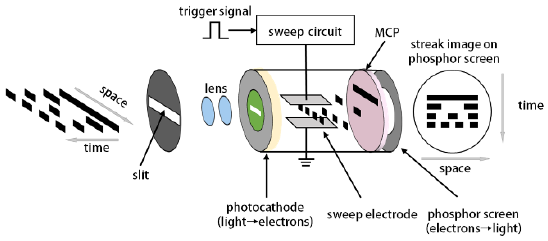
Figure 1. Schematic diagram of the imaging process of the streak camera in one-dimensional view.